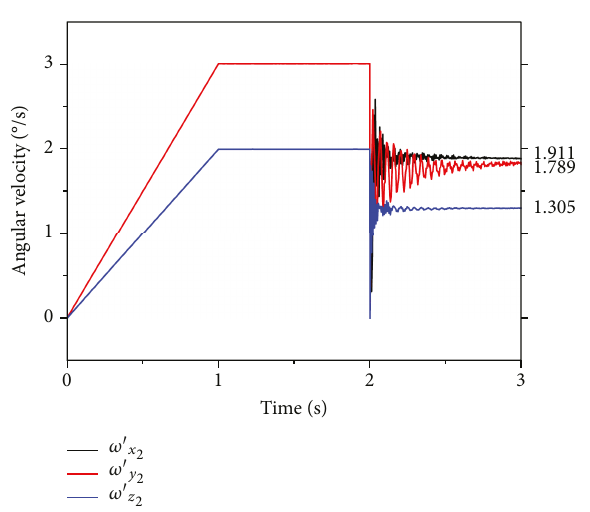
Figure 15: Simulation results of empty storage tank for ω ′ when ω ω z 1